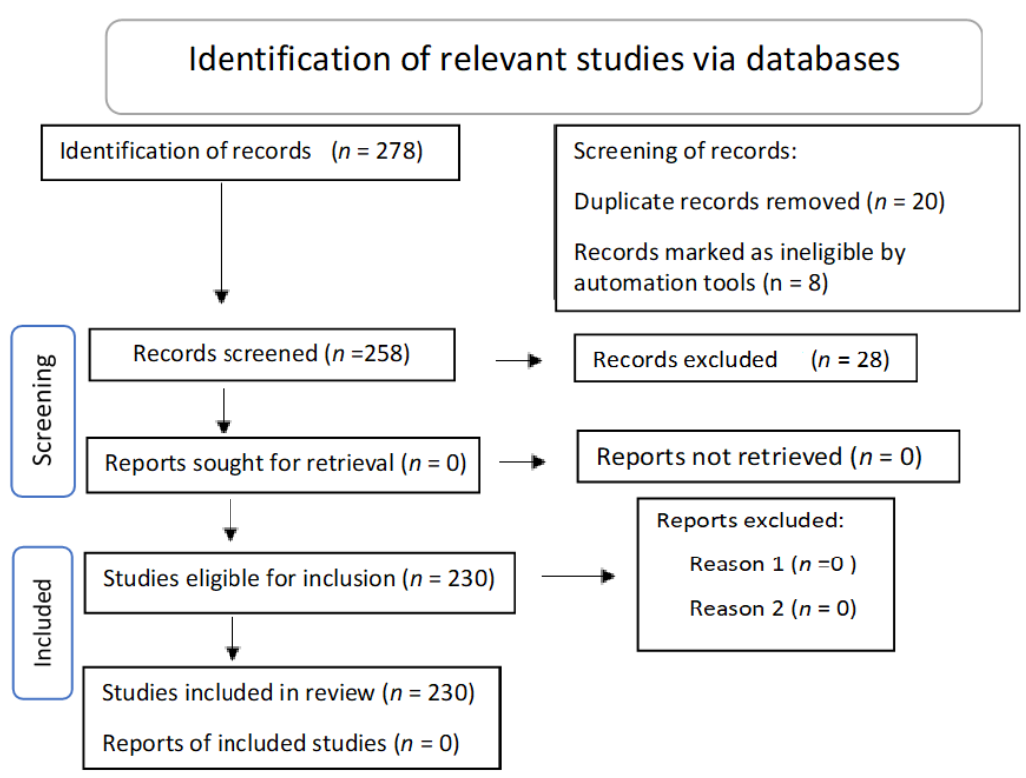
Figure 1. Prisma flow diagram for systematic review.